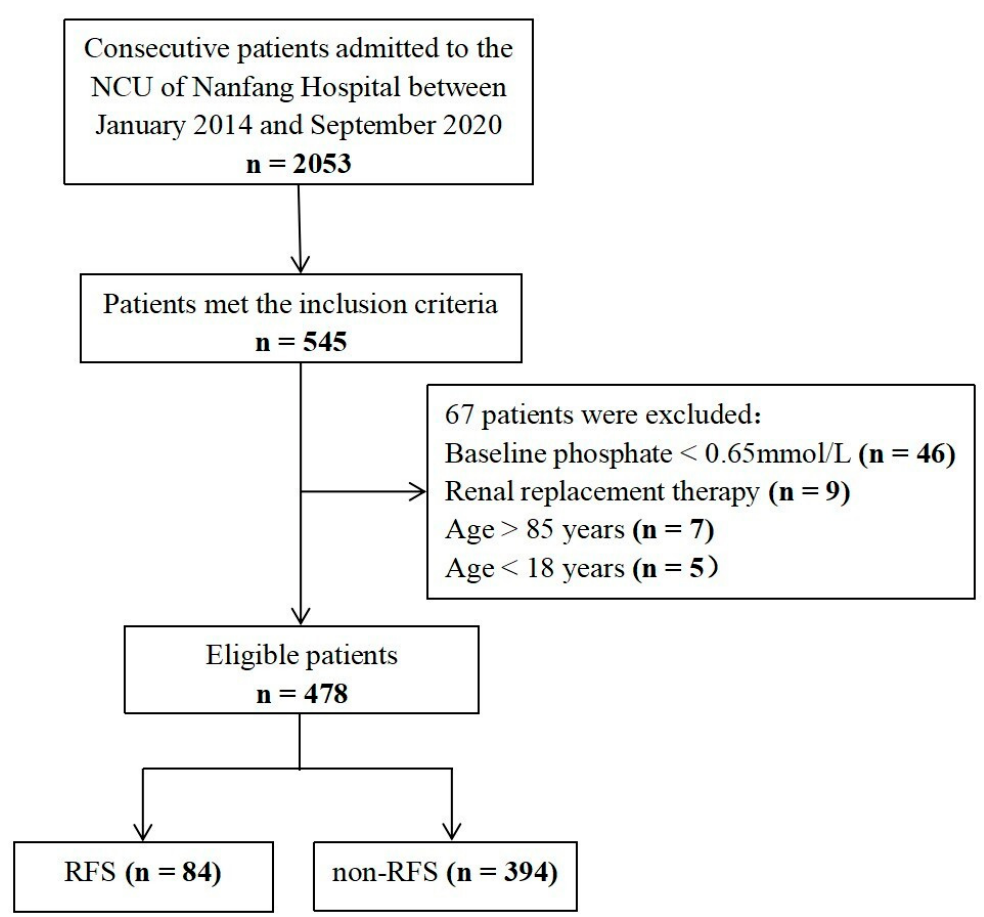
Figure 1. Patient inclusion flowchart.